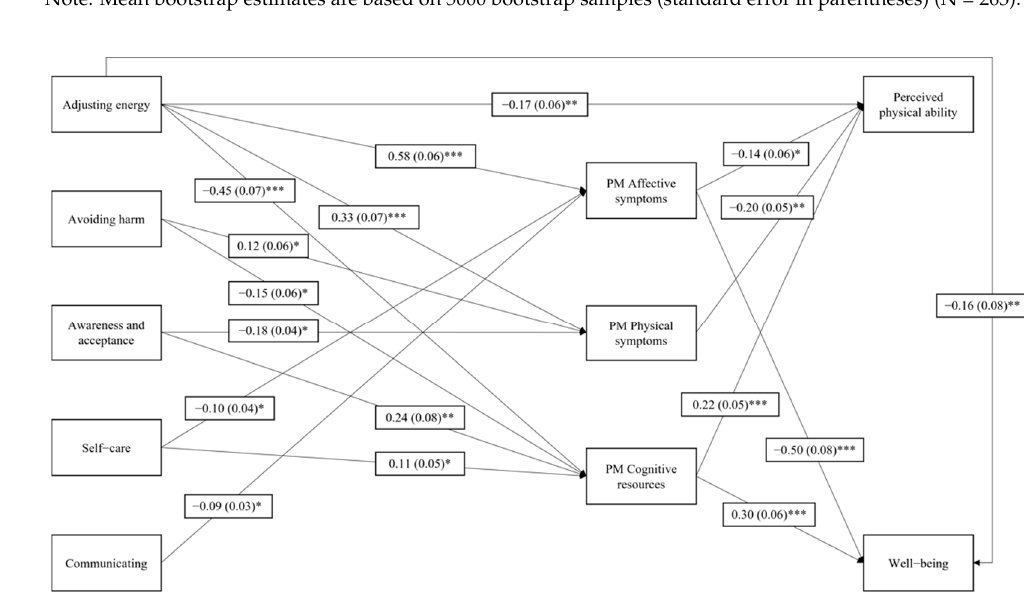
Figure 1. Mediation model of the effects of the five PM coping strategies via PM affective and physical symptoms and PM cognitive resources on perceived physical ability (PPA) and well-being. Only significant paths are reported (unstandarized coefficients; standard errors in parentheses; N = 263); * p < 0.05, ** p < 0.01, *** p < 0.001.